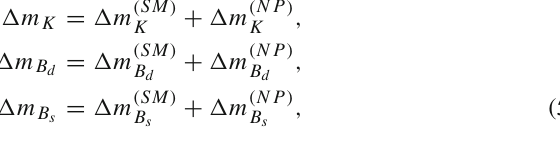
We plot in Fig. 4 the allowed region in the m Z (cid:2) − g X plane, consistent with the constraint arising from B 0 − ¯ B 0 (right-plot) mixings. In our numerical and B 0 s s